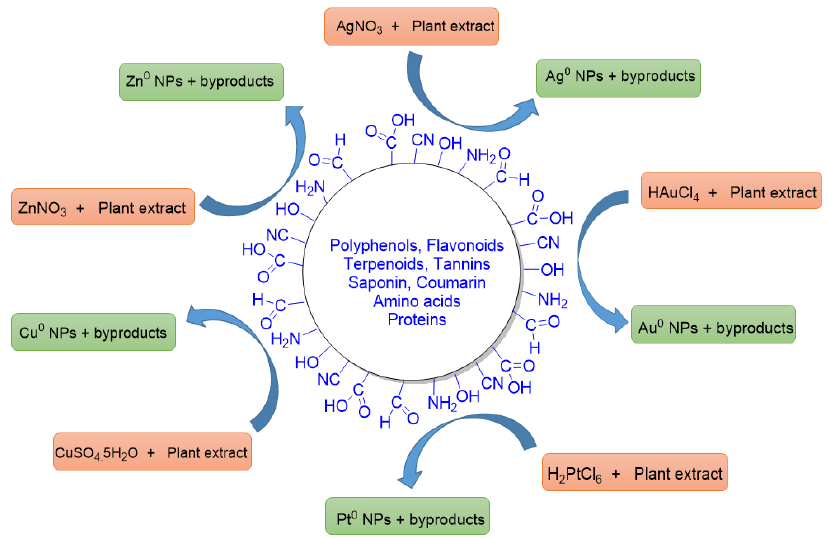
Figure 4. A diagrammatic representation of reducing abilities of functional groups (CHO, COOH, OH, NH 2 , CN, etc.) of bioactive compounds that are present in the various plant extracts. These functionalities reduce the metal ions into their zero valent states. Some byproducts are also formed in the